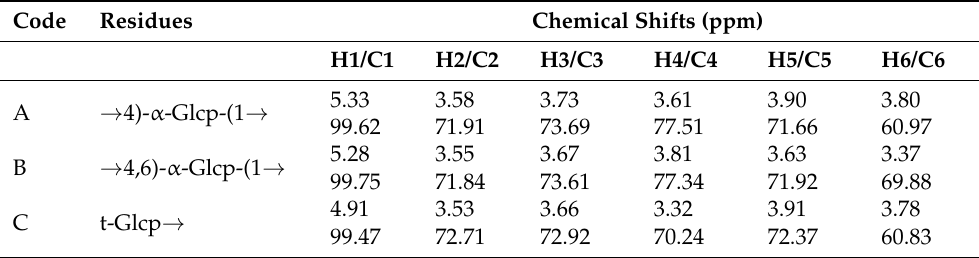
Table 3. Chemical shifts of the main residues of